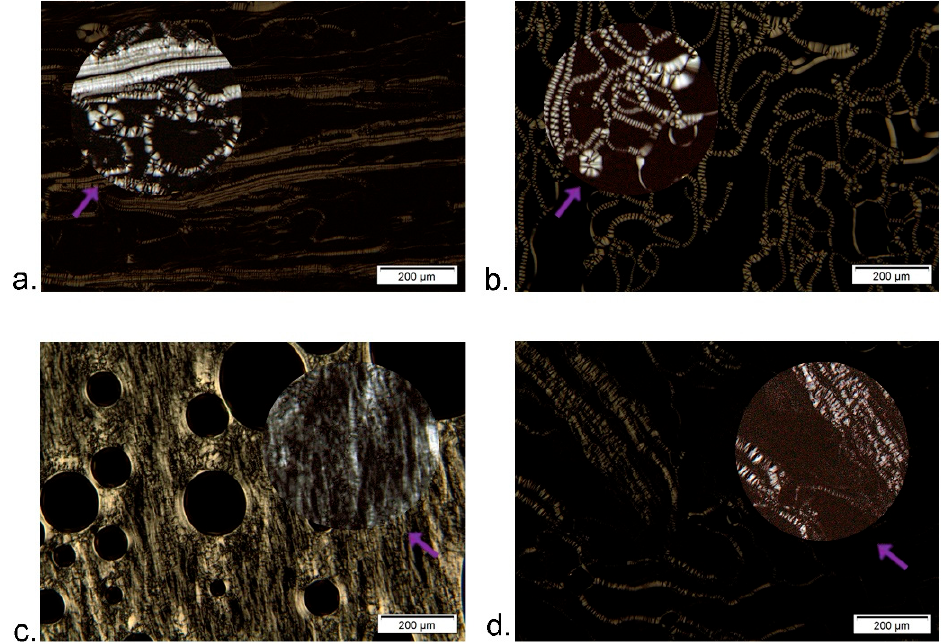
Figure 3. Optical textures under polarized light of the polyglycerol ester-based surfactant mix (S mix = P4L: TS 1:1)/water phase (glycerol/water) binary mixtures: ( a ) S mix 70 wt%, 30 wt% (5 wt% glycerol in water) and ( b ) S mix 46 wt%, 54 wt% water phase (5 wt% glycerol in water) exhibit lamellar phase with oily streaks and Maltese crosses and optically isotropic regions (dark); ( c ) S mix 70 wt%, 30 wt% (30 wt% glycerol in water) exhibits hexagonal phase and air bubbles—dark circles ( d ) S mix 46 wt%, 54 wt% water phase (30 wt% glycerol in water) exhibits hexagonal phase (bright) and isotropic domains (dark). Micrographs were taken at 100 magnification, and the close-up of the prominent anisotropic structures are marked with purple arrows (up to 400 × magnifica- tion).